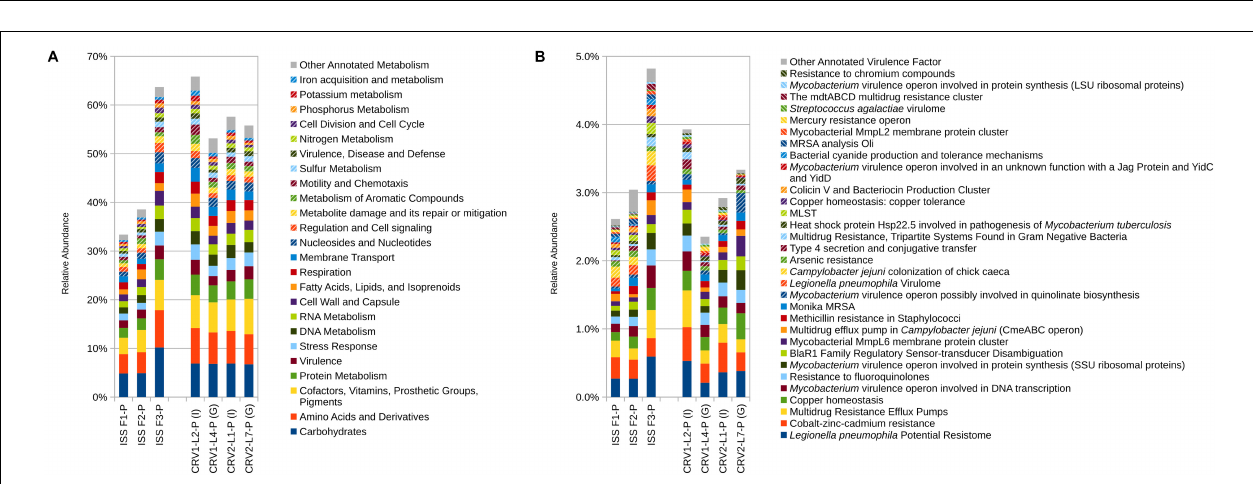
FIGURE 3 | Relative abundance of metagenomic reads associated with (A) microbial metabolism and (B) virulence. Metagenomic reads were generated from PMA treated samples collected from three sampling events on the ISS and the internal (I) and ground support equipment (G) surfaces of CRV1 and CRV2.